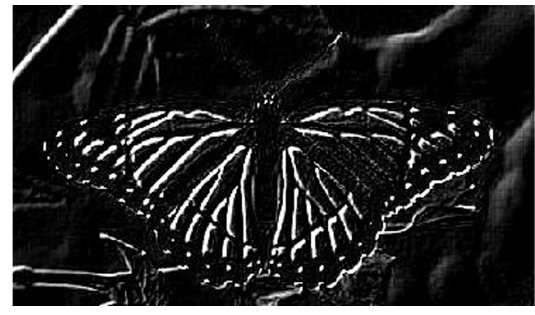
Figure 8. MATLAB result of Prewitt Operator.